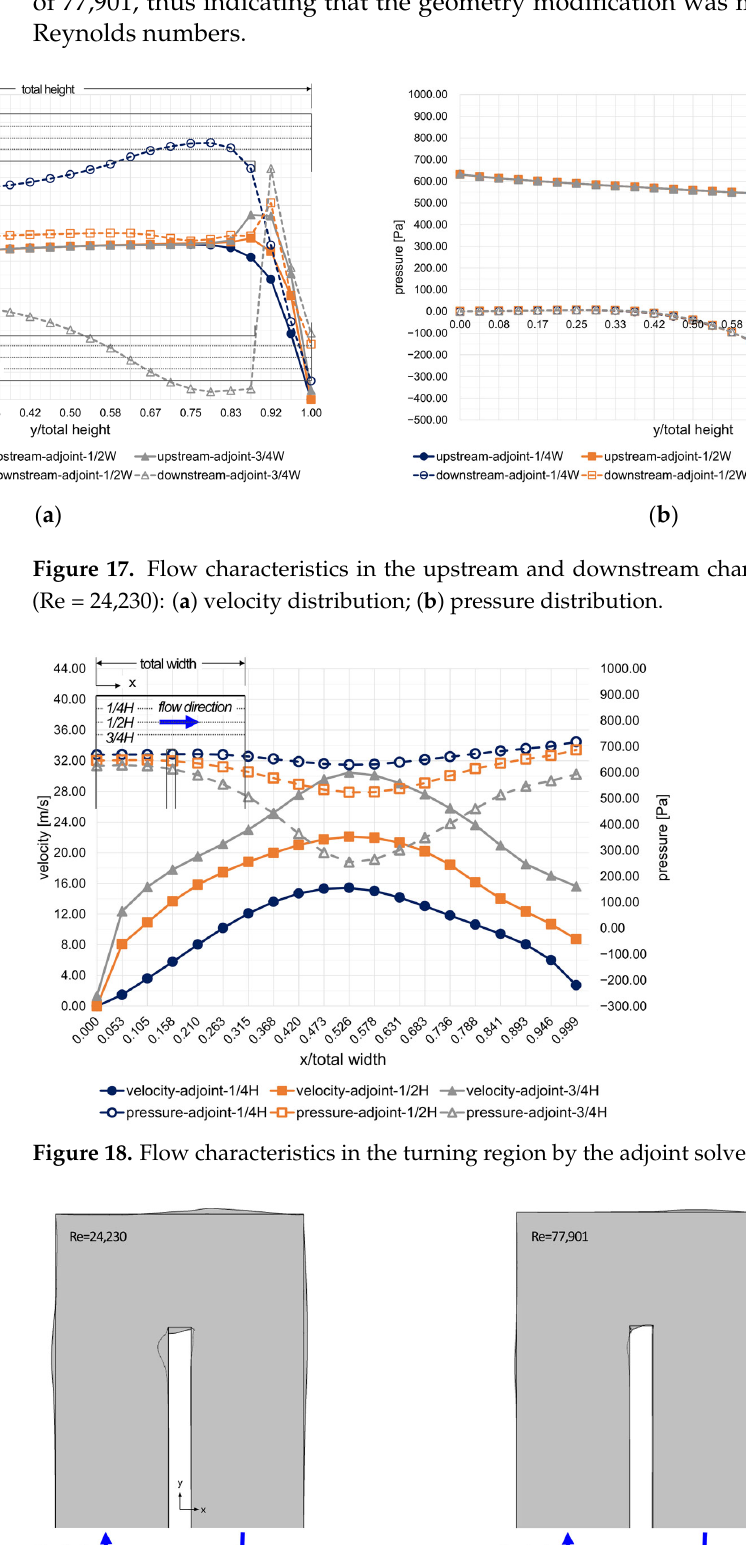
Figure 19. Geometry modi fi cation using the adjoint solver: ( a ) Re = 24,230; ( b ) Re = 77,901. 5. Conclusions In this study, the TPLC prediction in a sharp 180-degree turn with a rectangular chan- nel, widely used in blade cooling system, was investigated using a numerical method. Then, the in fl uence of input variables and geometry changes on the TPLC, data-based prediction models using R, and the e ff ect of minimal geometry change on the TPLC were investigated. The conclusions are as follows: 1.